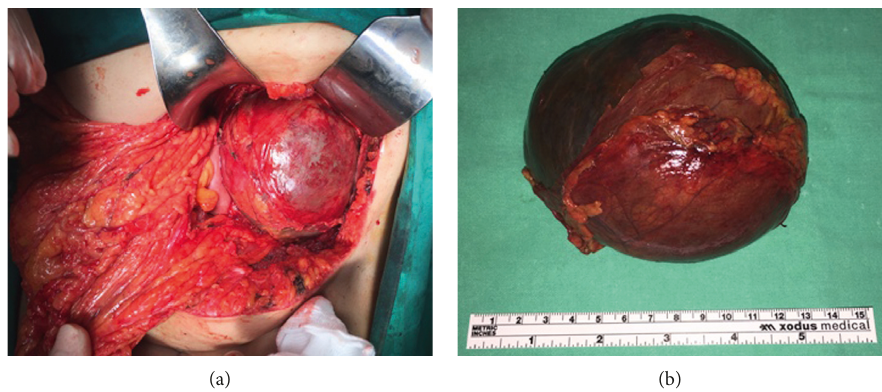
Figure 2: (a) Intraoperative findings. (b) Final specimen after surgical resection.